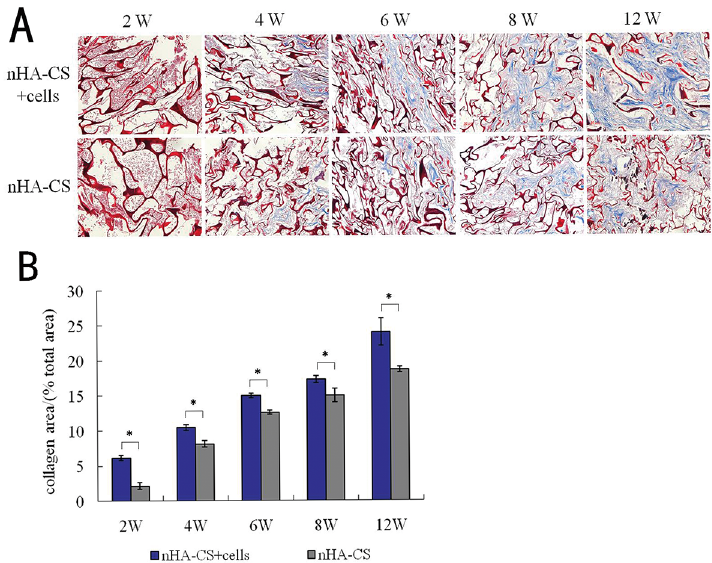
Fig 6. Histological examination of Masson's trichrome staining. (A) Representative Masson's trichrome staining images showing the expression of collagen in the two groups at different time points (figure magnification 100×). (B) The analysis of the proportions of the collagen area indicate that significantly more collagen was present in the nHA-CS+cells group than the nHA-CS group ( * P < 0.05), indicating that the nHA-CS+cells group formed more de novo bone than the nHA-CS+cells group.